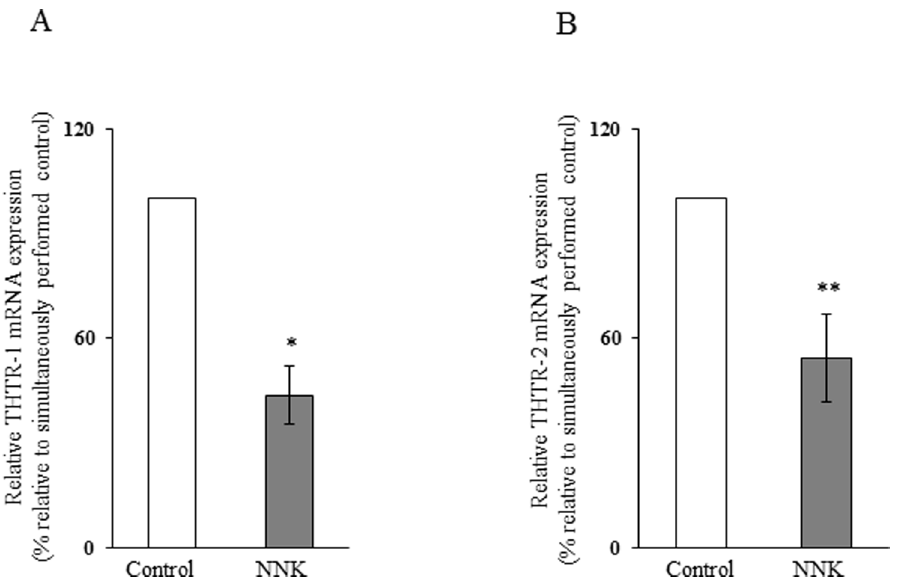
Figure 3. Effect of chronic exposure of pancreatic acinar 266-6 cells to NNK on the level of expression of THTR-1 and THTR-2 mRNA. Q PCR was performed using mice THTR-1 (A) and THTR-2 (B) gene-specific primers and cDNA prepared from NNK exposed as well as control 266-6 cells RNA. Data are mean 6 SE of at least 3 independent experiments and were normalized relative to ARPO and calculated by the relative relationship method. * P , 0.01, ** P , 0.05.